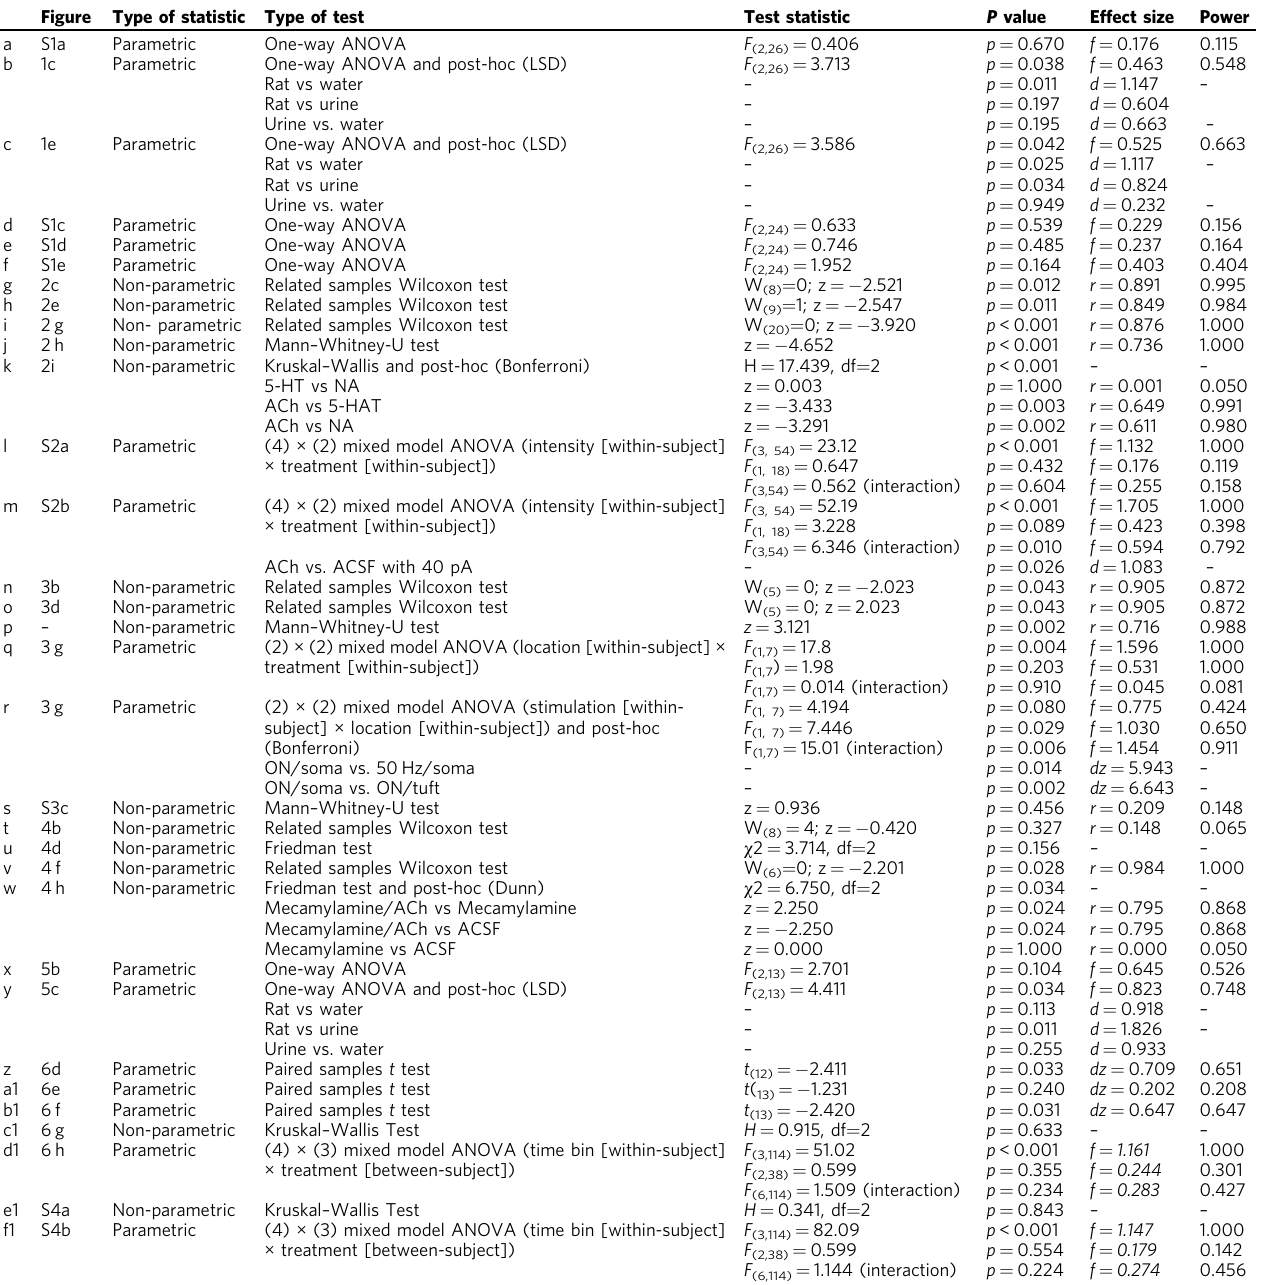
Table 1 Statistical overview. Figure Type of statistic Type of